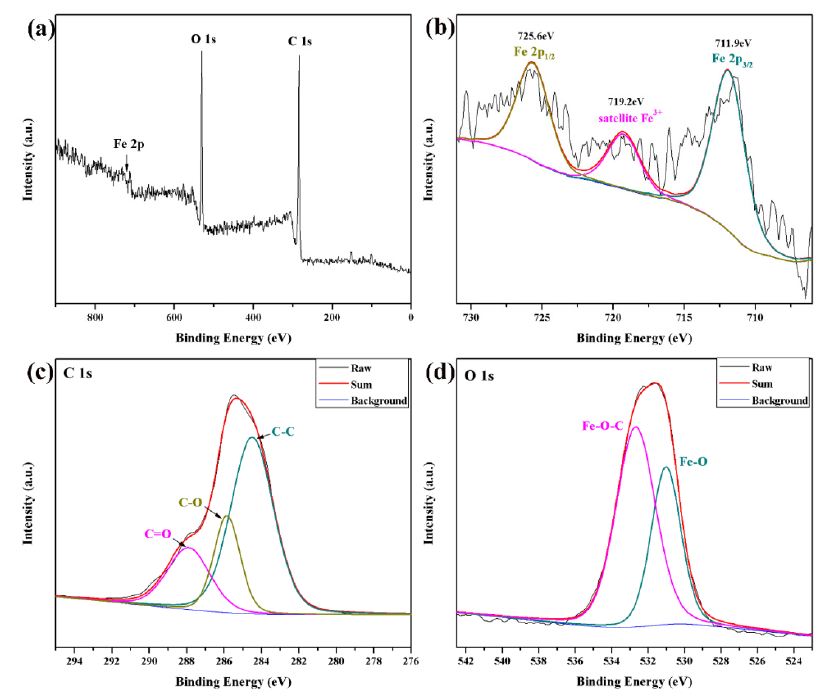
Figure 7. XPS spectra of ( a ) Fe 2 O 3 /CNFs; ( b ) Fe 2p; ( c ) C 1 s; ( d ) O 1 s.